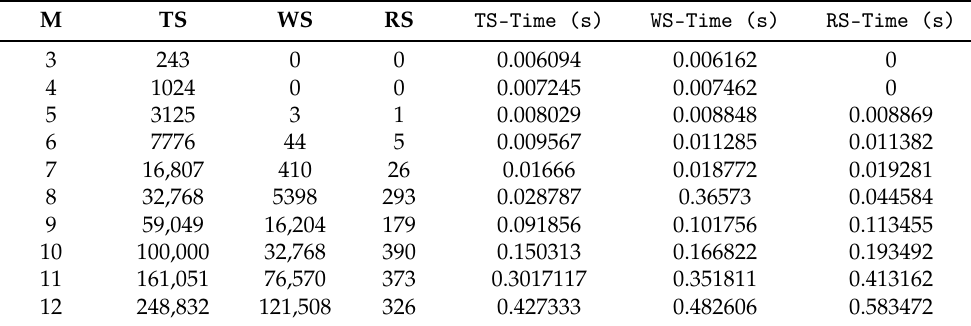
Table 4. n = 5, k 1 = 200, average of ten runs.